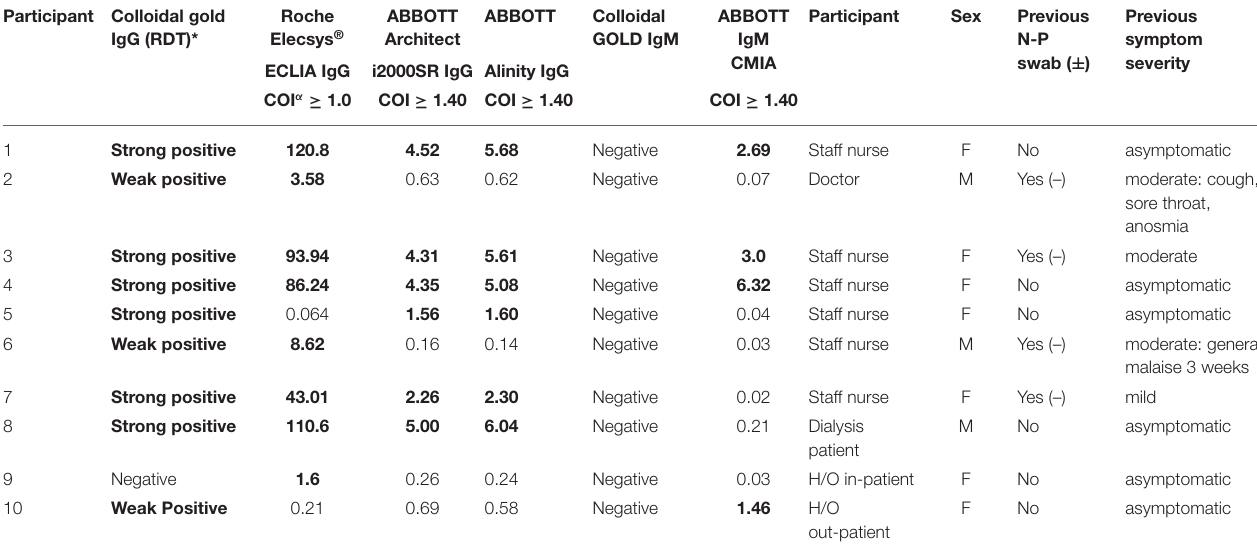
* The results of rapid antibody testing are included here but were not a contributing factor in deeming a participant positive. All results highlighted in bold were a positive result in that particular test. α Cut-off Index.